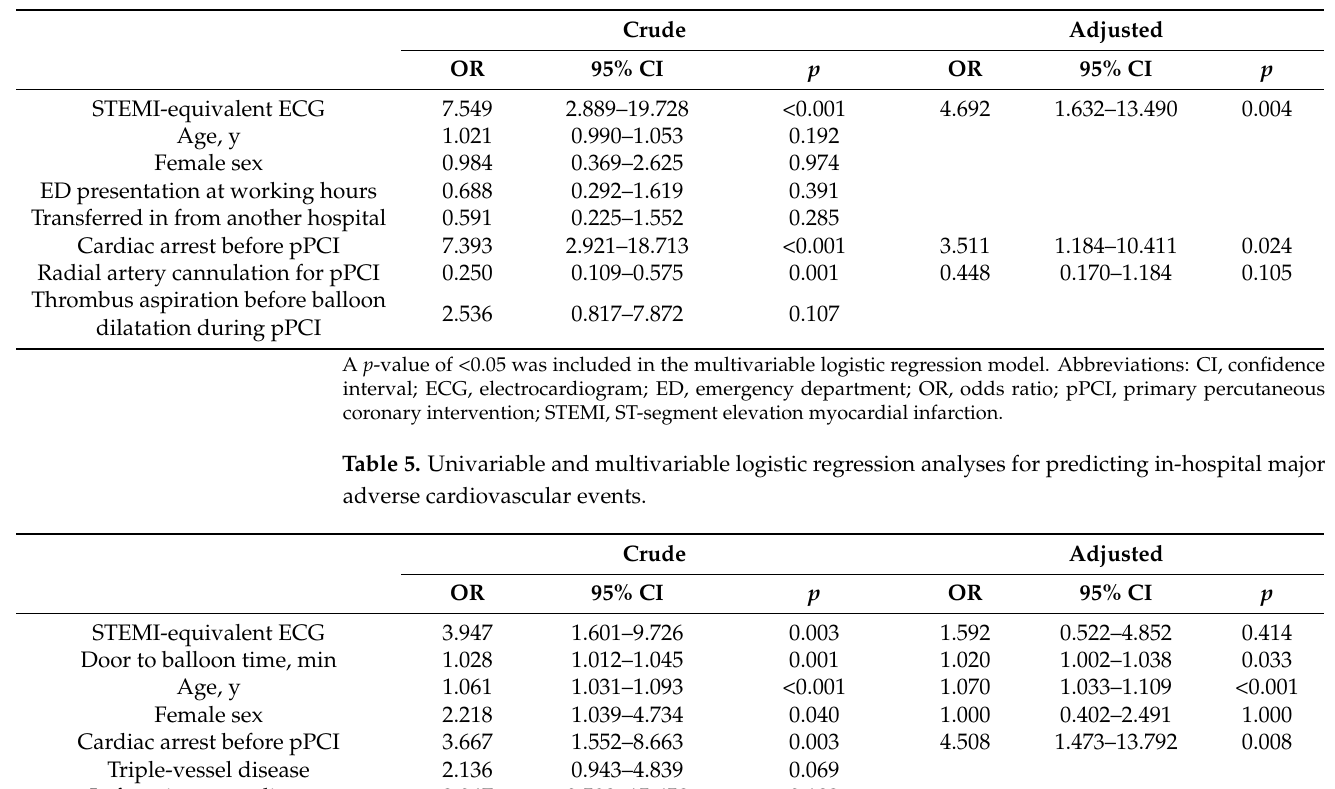
Table 4. Univariable and multivariable logistic regression analyses for predicting delayed door-to- balloon time for more than 90 min.